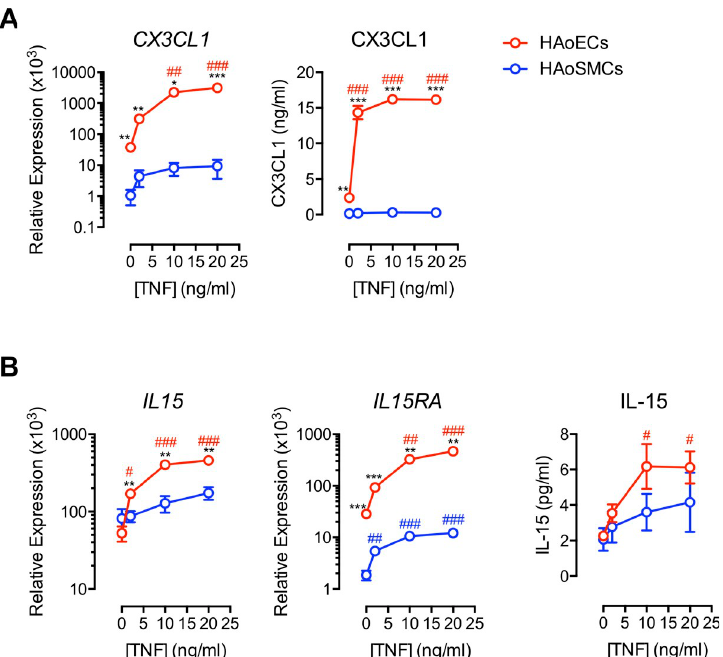
Fig 5. TNF induces primary HAoEC expression of CX3CL1 and IL-15. HAoECs and HAoSMCs were cultured for 7 days in the presence of TNF or medium control. (A) Relative CX3CL1 expression compared to GAPDH (left) and CX3CL1 secretion (right) in HAoECs (n = 3) and HAoSMCs (n = 3). (B) Relative expression of IL15 and IL-15RA compared to GAPDH (left and middle) and IL-15 secretion (right) in HAoECs (n = 3) and HAoSMCs (n = 3). Data are mean ± SEM. Differences between groups were determined by Mann-Whitney U test: � P � 0.05; �� P � 0.01; ��� P � 0.001. Differences within groups were determined by Kruskal-Wallis test with Dunn’s correction: # P � 0.05; ## P � 0.01; ### P � 0.001. HAoECs, human aortic endothelial cells; HAoSMCs, human aortic smooth muscle